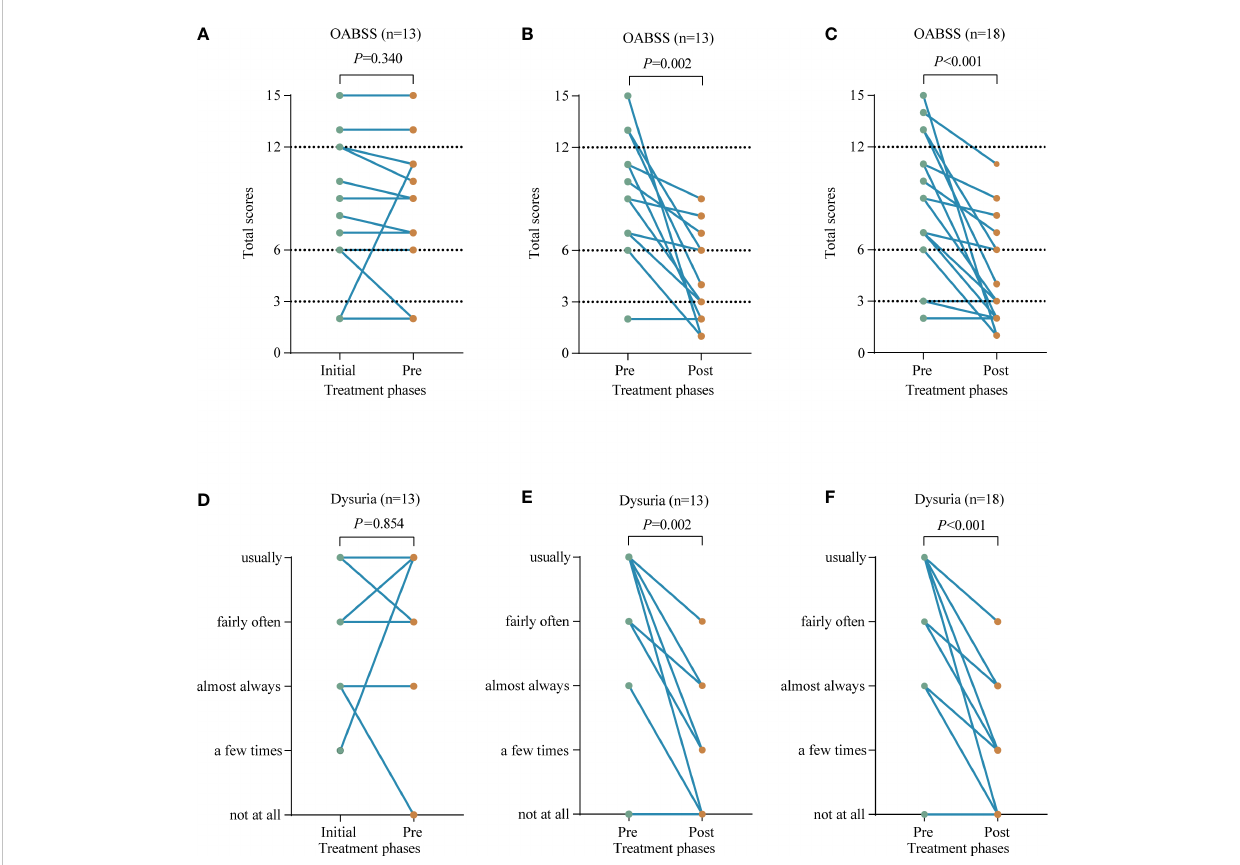
FIGURE 5 Compare the voiding symptoms before and after receiving anti-infective treatment in terms of overactive bladder syndrome score (OABSS) and dysuria. (A, D) The changes in symptom before (Initial) and after (Pre) receiving empirical anti-infective treatment in these 13 patients. (B, E) The changes in symptom before (Pre) and after (Post) the above 13 patients were re-treated with targeted anti-infection therapy. (C, F) The changes in symptom before (Pre) and after (Post) receiving targeted anti-infective treatment in 18